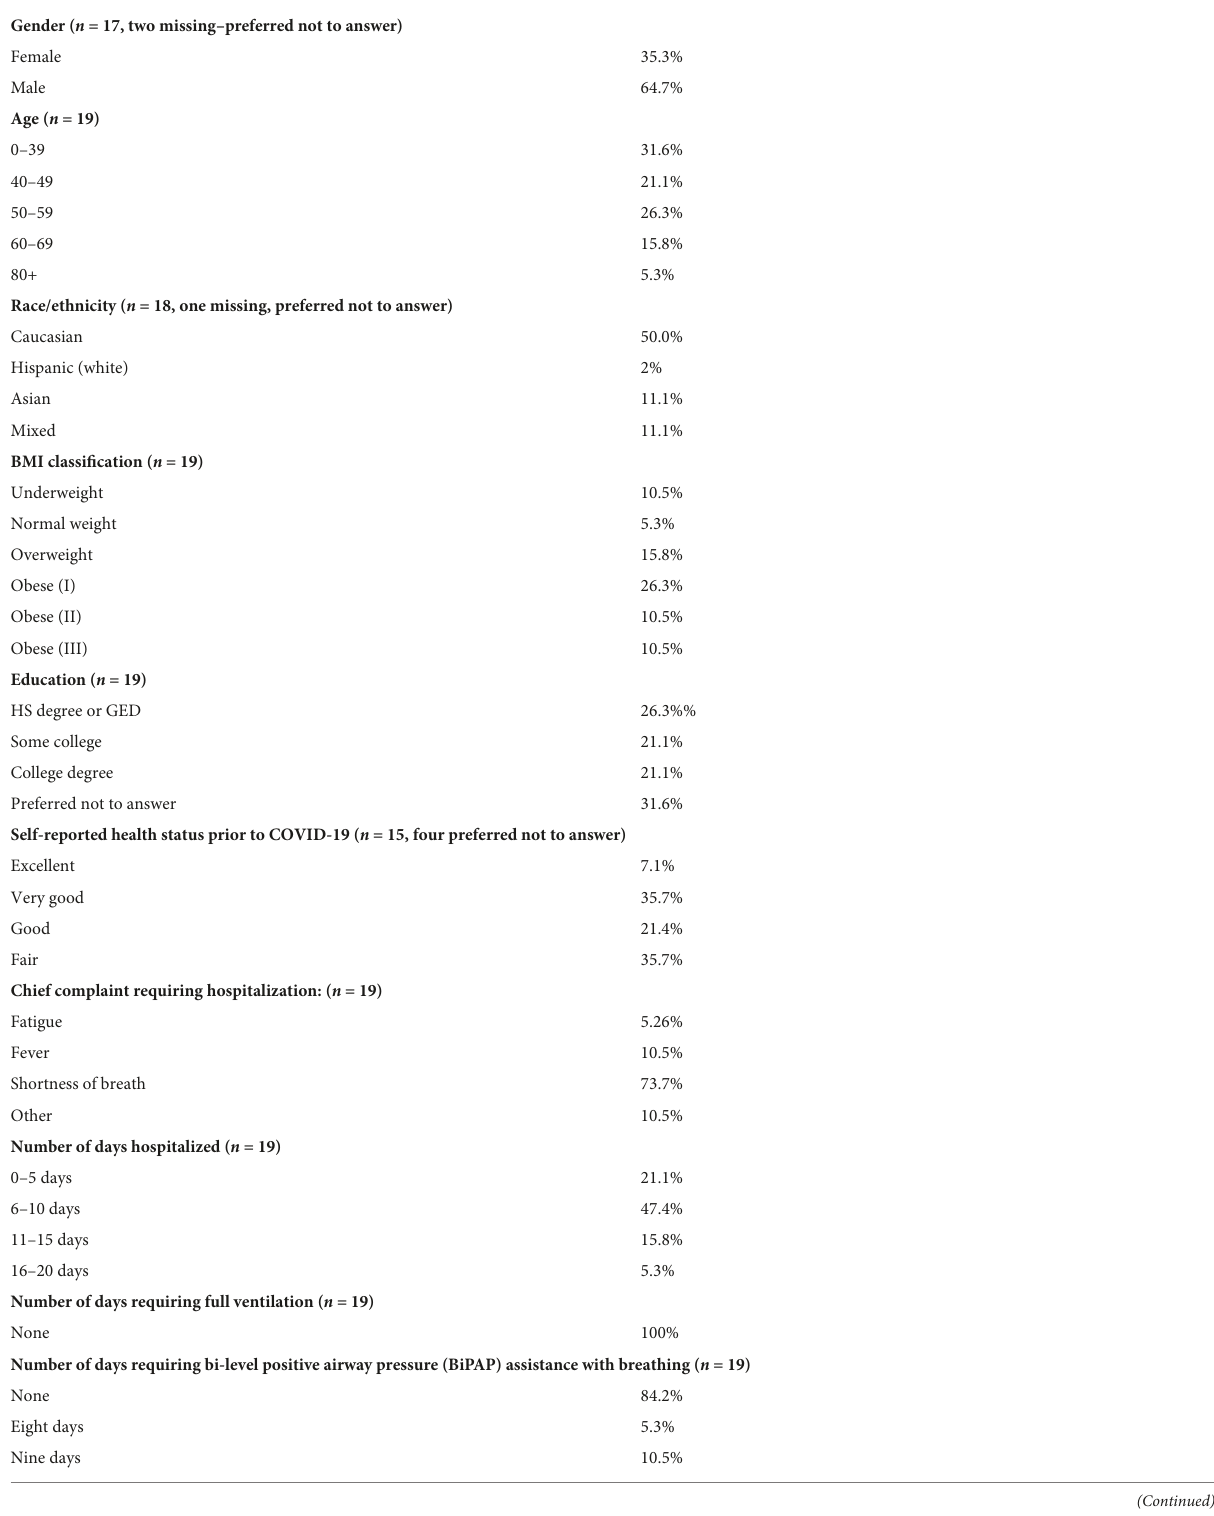
TABLE 1 Socio-demographic, patient chart data ( n = 20), and data gathered by nursing staff over time reported at weeks 1 and 4 (mean values with 95% CI) ( n = 15).